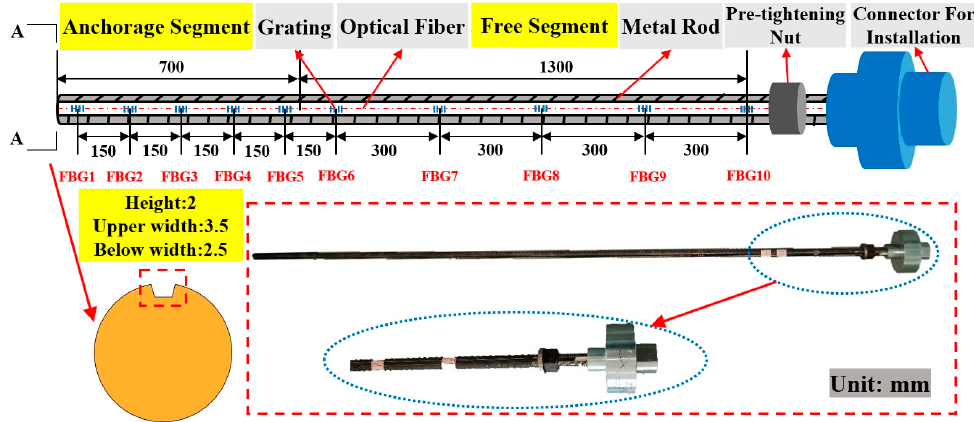
Figure 5. Structure of fiber bragg grating (FBG) force-measuring bolt.